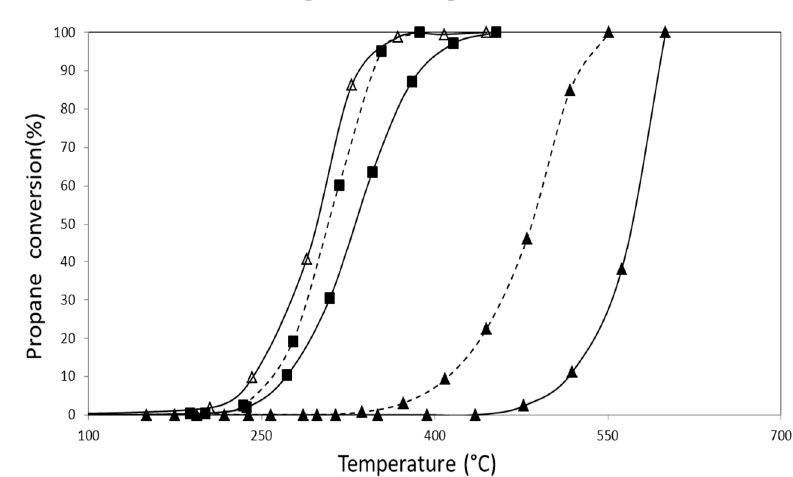
Figure 9. Propane combustion using a mixture of NO, O 2 and He as oxidizing agent for the catalysts ( ♦ ) CoZ, ( (cid:7) ) AuZ, ( • ) AuCoZ, (– (cid:7) –) AuDpZ, (– • –) AuDpCoZ.